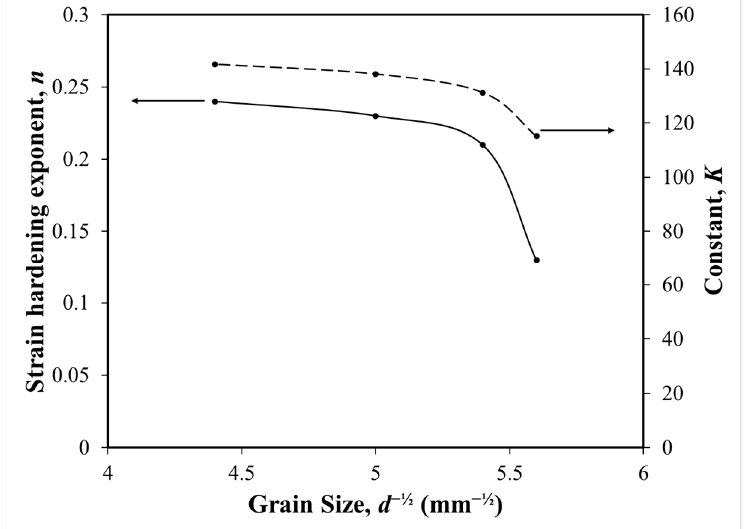
Figure 10. Effect of grain size on the strain-hardening exponent and constant K.